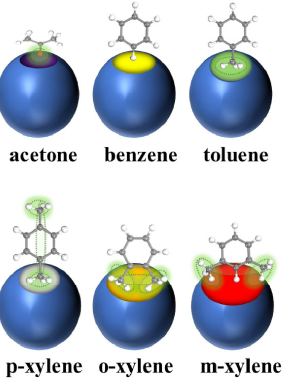
Figure 2. Scheme for entry of acetone, benzene, toluene, p-xylene, o-xylene, and m-xylene into UiO-67 pores [10].